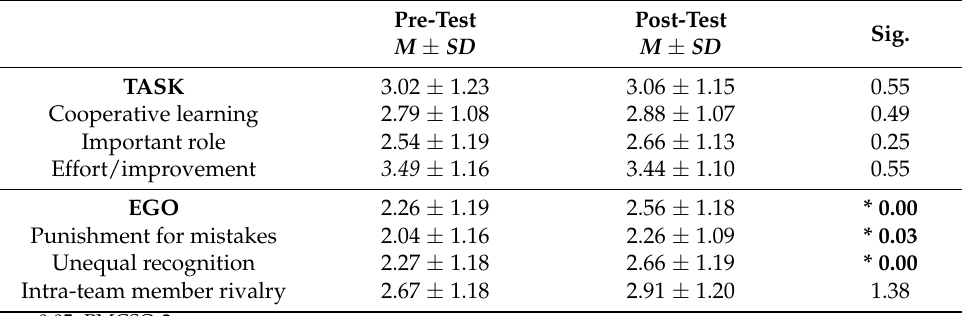
Table 5. The results of the PMCSQ questionnaire in Test group 2.